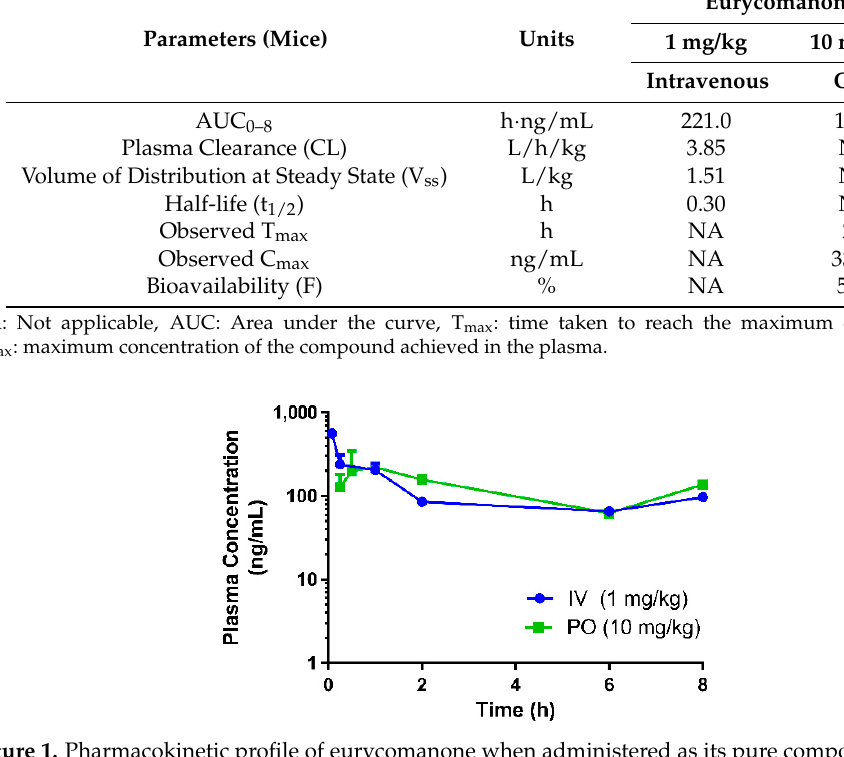
Figure 1. Pharmacokinetic profile of eurycomanone when administered as its pure compound in mice. (IV = intravenous route, PO = oral route)